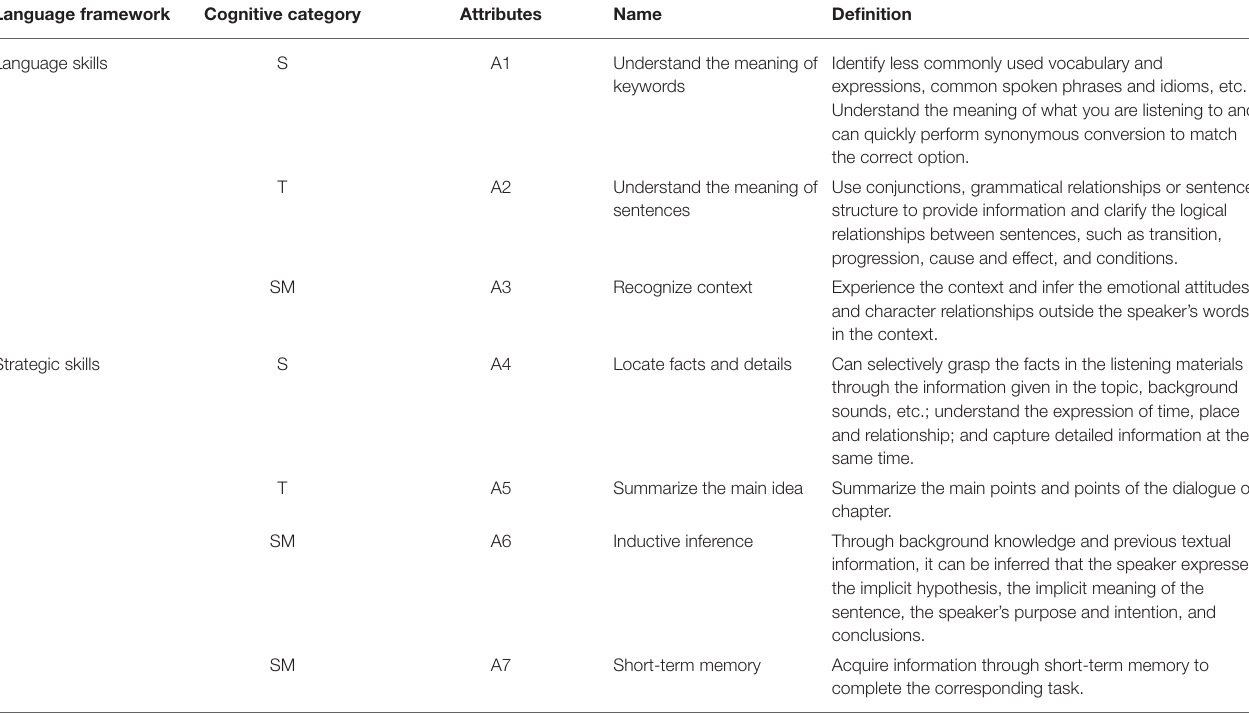
TABLE 2 | Definition of Chinese-as-a-second language (CSL) listening cognitive